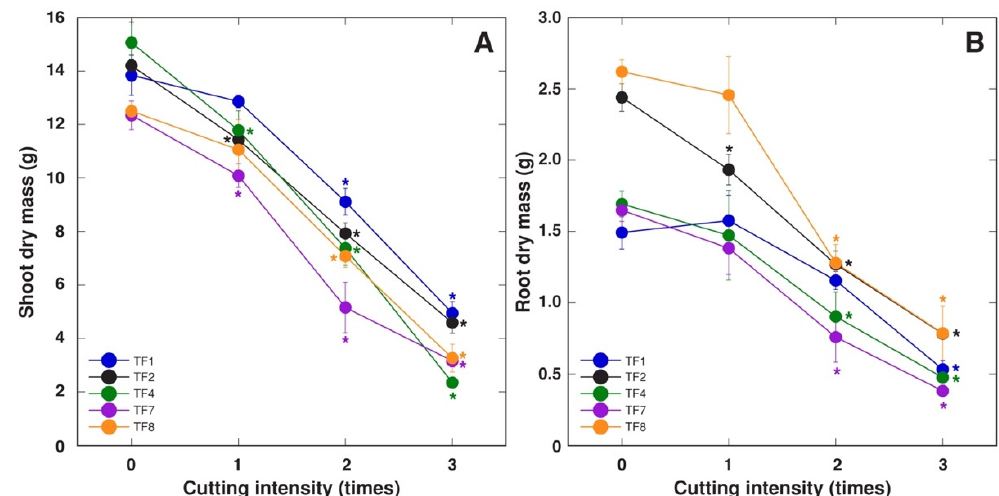
Figure 7. Effect of increasing cutting intensity on shoot dry mass ( A ) and root dry mass ( B ) of Trifolium fragiferum plants of different accessions. Data are means ± SE from five plants. Measurements were performed after six weeks of treatment plus three weeks of recovery. Asterisks indicate statistically significant difference ( p < 0.05) from control for the respective accession.